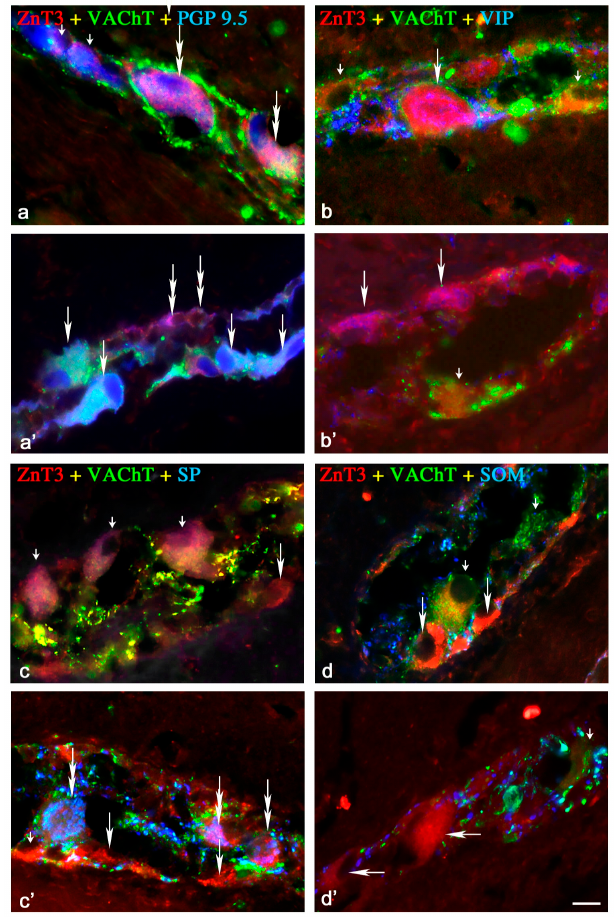
Figure 1. Representative images of ZnT3 + neurons located in the myenteric plexus (MP) of the porcine ileum: myenteric ganglia. All images are composites of merged images taken separately from blue, red and green fluorescent channels. Control (C) group: ( a ) ZnT3 + /VAChT + /PGP9.5 + neurons are indicated with double-headed arrows, ZnT3 − /VAChT − /PGP9.5 + neurons are indicated with small arrows; ( b ) ZnT3 + /VAChT + /VIP + neurons are indicated with an arrow, ZnT3 + /VAChT + /VIP − neurons are indicated with small arrows; ( c ) ZnT3 + /VAChT + /SP − neurons are indicated with small arrows; ZnT3 + /VAChT − /SP − neurons are is indicated with arrows; ( d ) ZnT3 + /VAChT + /SOM − neuron is indicated with a small arrow; ZnT3 + /VAChT − /SOM − neurons are indicated with arrows. Inflammatory (I) group ( a’ ) ZnT3 + /VAChT + /PGP9.5 + neurons are indicated with arrows, ZnT3 + /VAChT − /PGP9.5 + neurons are indicated with double-headed arrows; ( b’ ) ZnT3 + /VAChT − /VIP + neurons are indicated with arrows; ZnT3 + /VAChT − /VIP − neurons are indicated with a small arrow; ( c’ ) ZnT3 + /VAChT + /SP − neuron is indicated with a small arrow; ZnT3 + /VAChT − /SP + neurons are indicated with double-headed arrows; ZnT3 + /VAChT − /SP − neurons are indicated with arrows; Control group ( d’ ) ZnT3 + /VAChT + /SOM − neuron is indicated with a small arrow; ZnT3 + /VAChT − /SOM − neurons are indicated with arrows. Scale bar 25 µm.